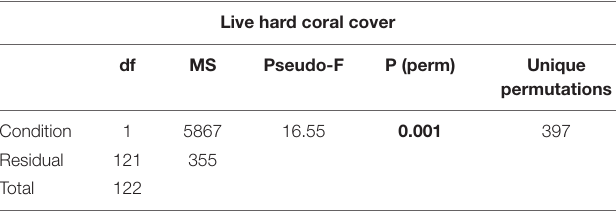
TABLE 2 | Results of one-way PERMANOVA on live hard coral cover in shallow reefs (5 m depth) between atolls with high human pressure (North Malé and South Malé) and atolls with low local human pressure after the bleaching event of